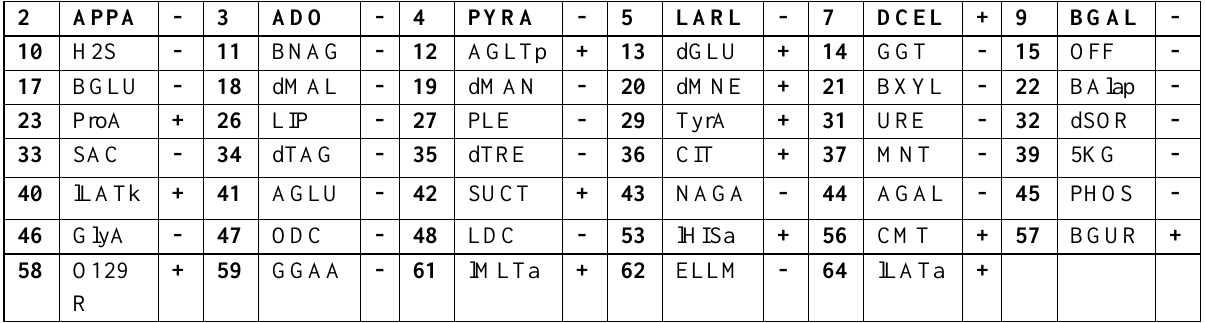
Table 1. Vitek 2 identification result of Acinetobacter baumannii.